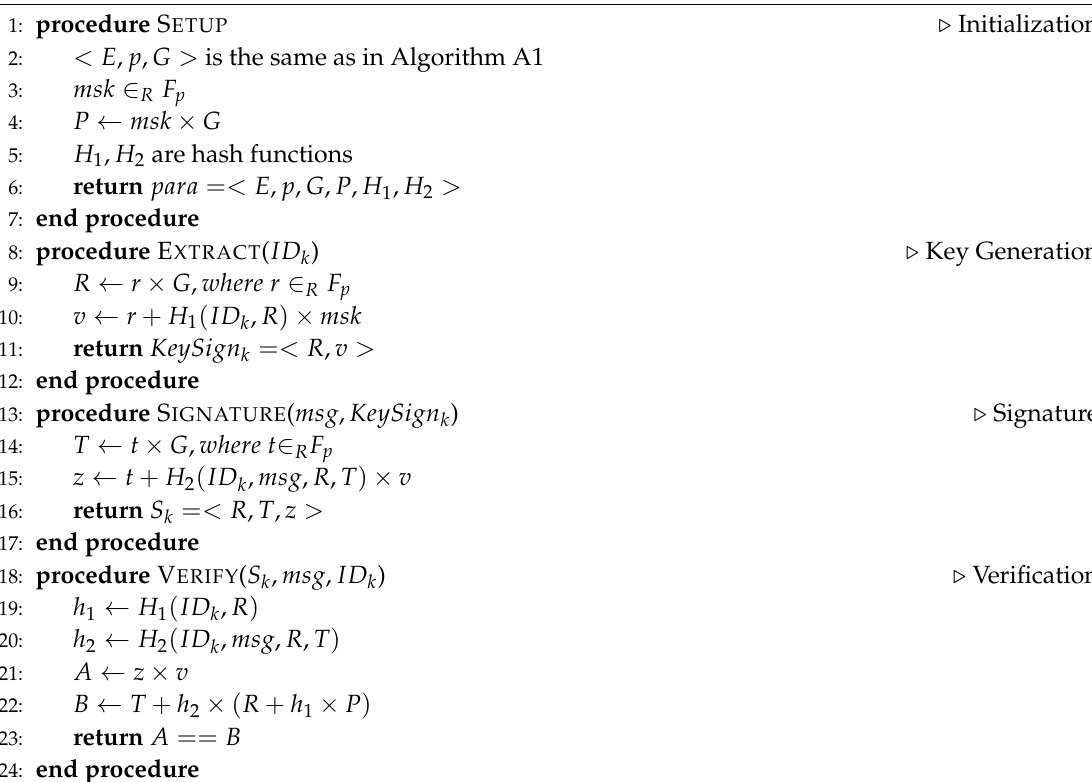
Algorithm A2 Identity-based signature